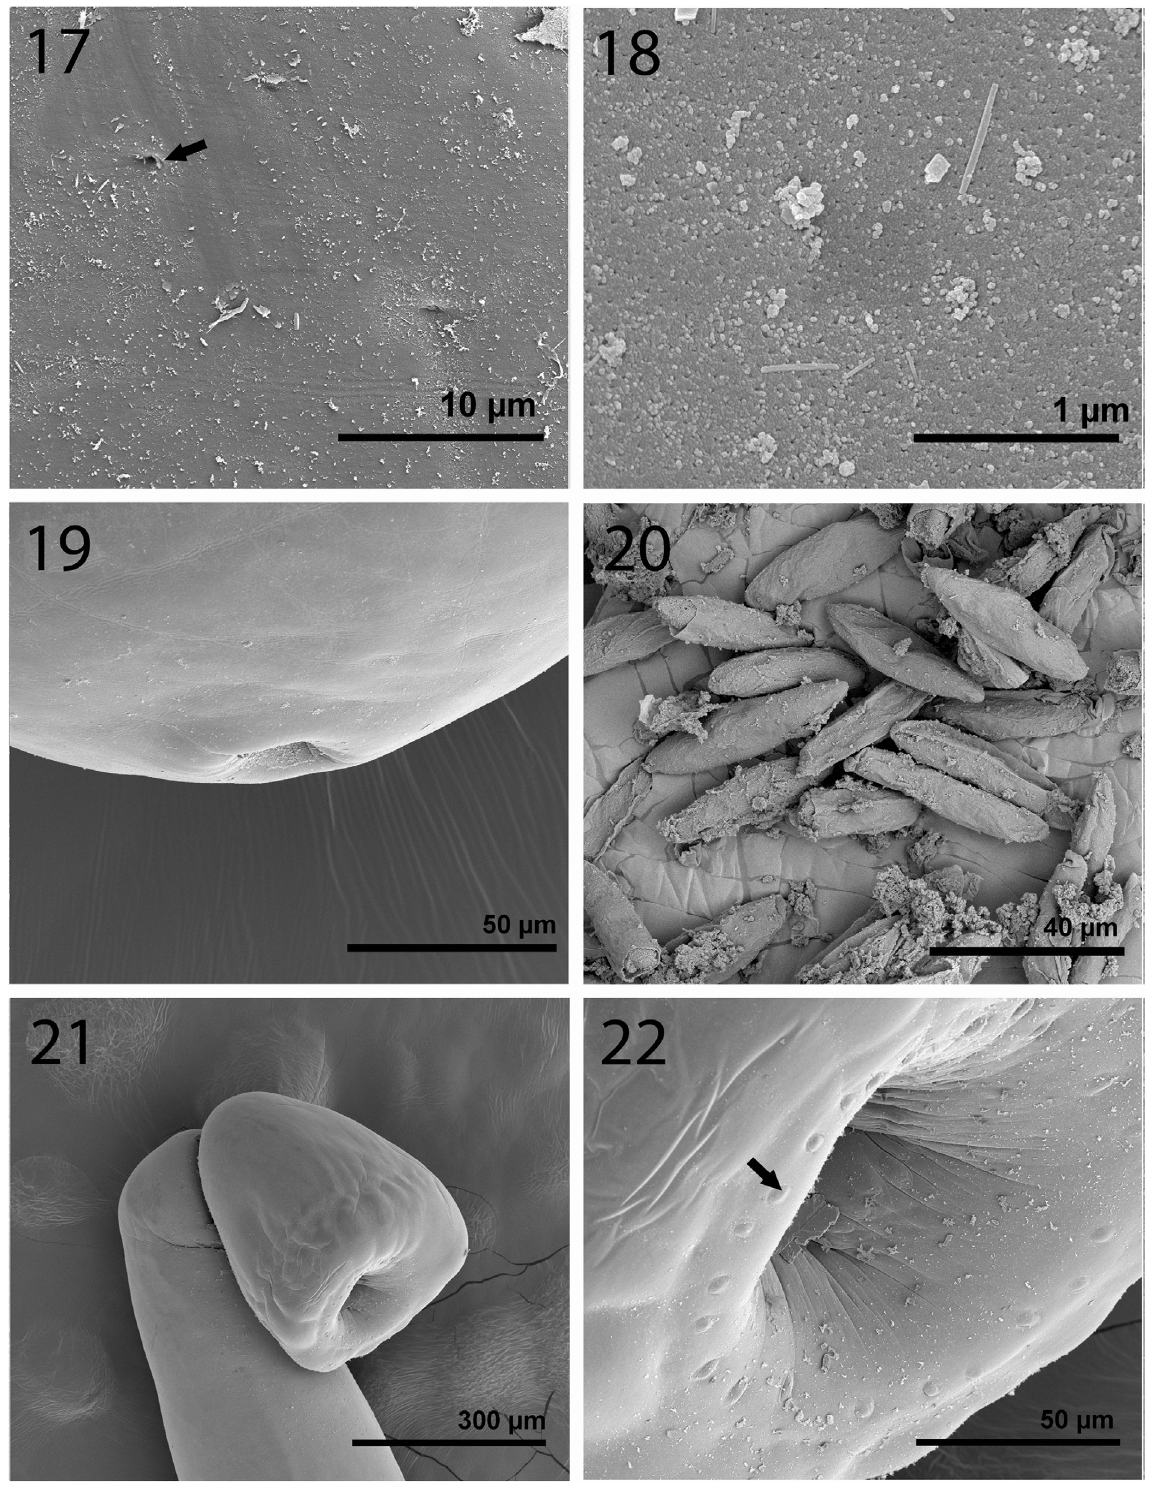
Figures 17–22. SEM of mature specimens of Echinorhynchus baeri from S. trutta in Turkey. 17. Sensory pore (arrow) at the base of the proboscis. No micropores here. 18. Epidermal micropores at midtrunk. 19. The posterior end of a female specimen showing terminal gonopore. 20. Egg mass from a dissected female specimen. 21. Bursa of a male specimen. 22. The opening of the bursa showing one ring of sensory knobs